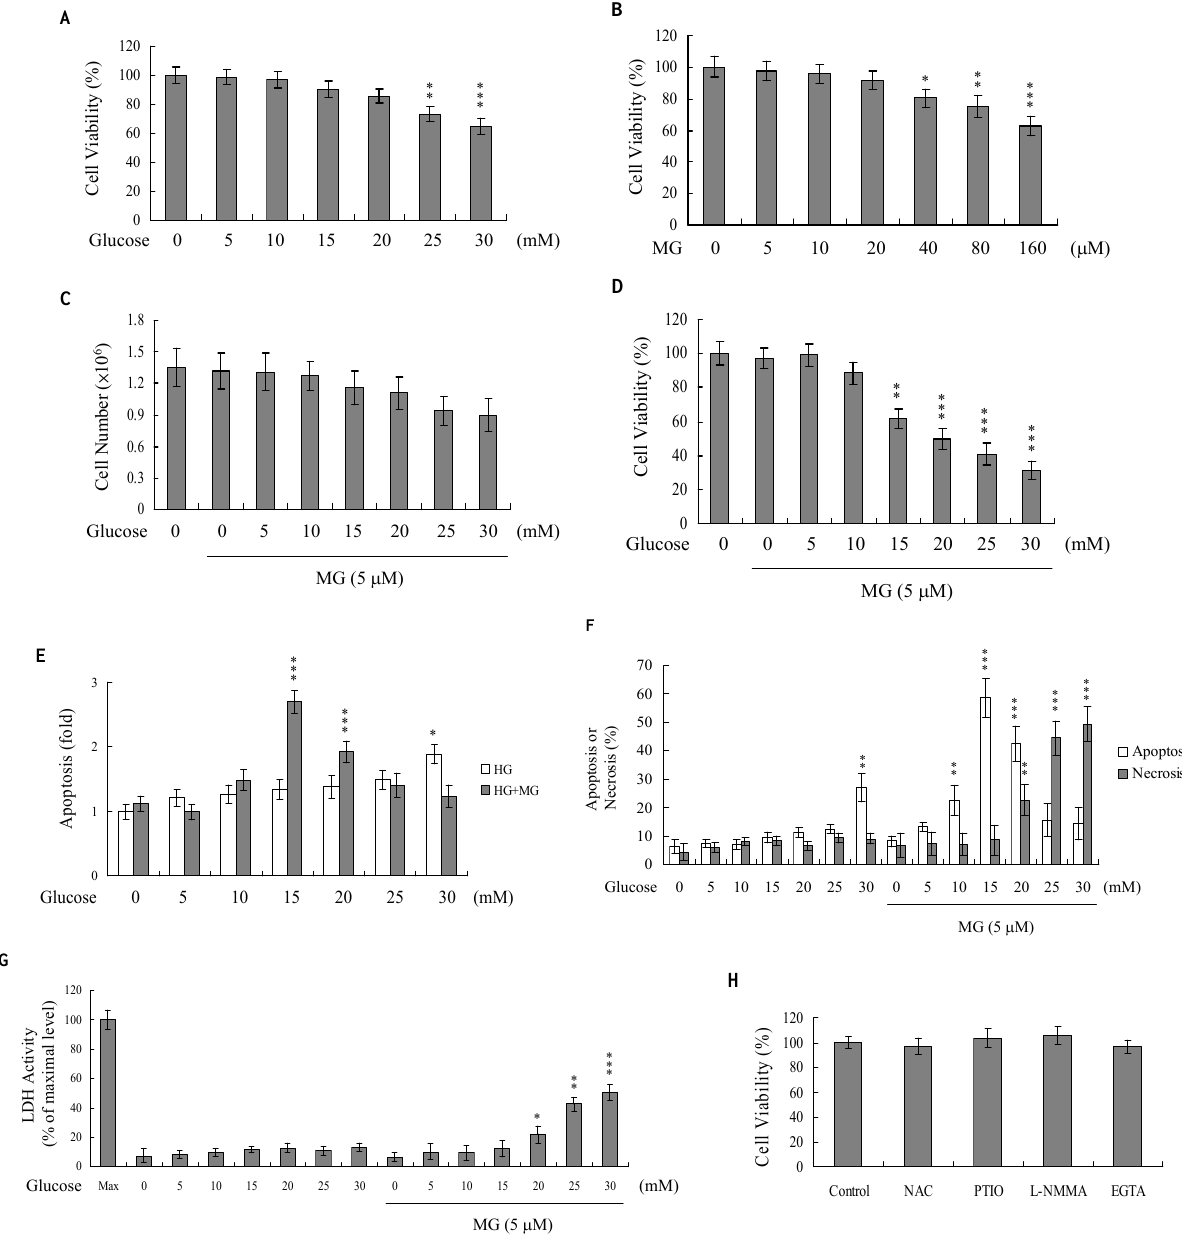
Figure 1. Effects of MG and HG on